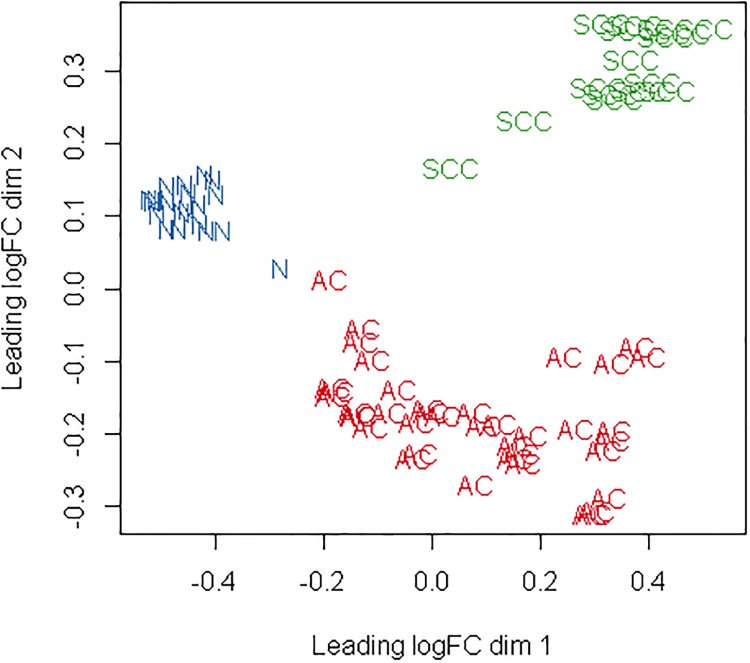
Clustering of samples.